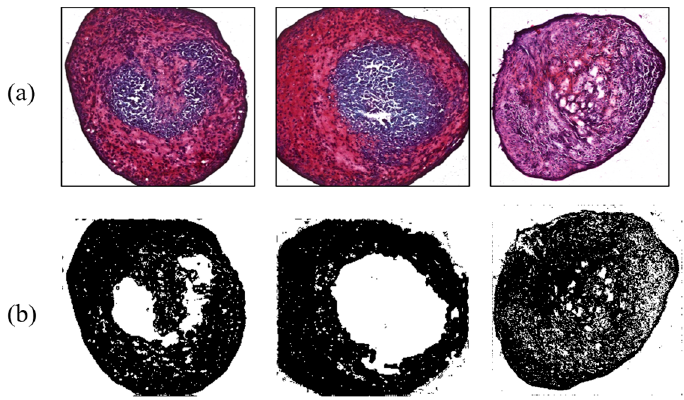
Figure 9. Ultrasonic effect on chondrogenesis for the flat tip. ( a ) Safranin-O-stained MSCs; ( b ) ImageJ results.